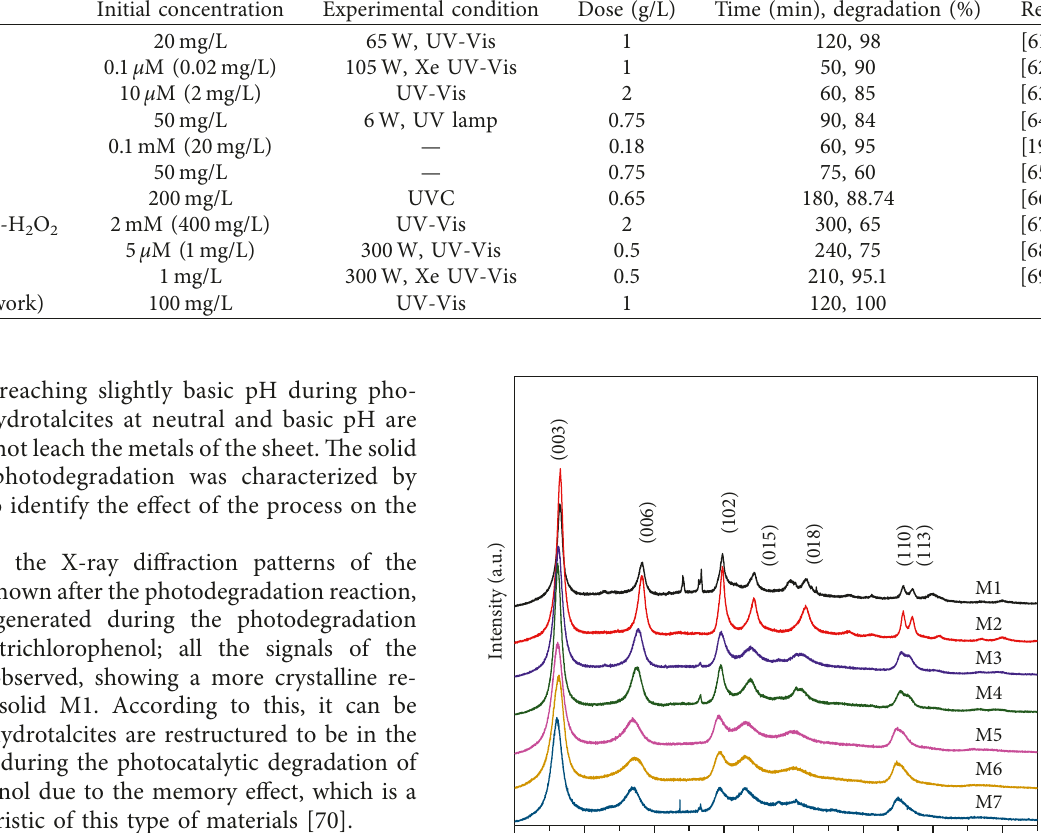
Table 6: Comparison of different photocatalysts used in 2,4,6-trichlorophenol photodegradation. Photocatalyst